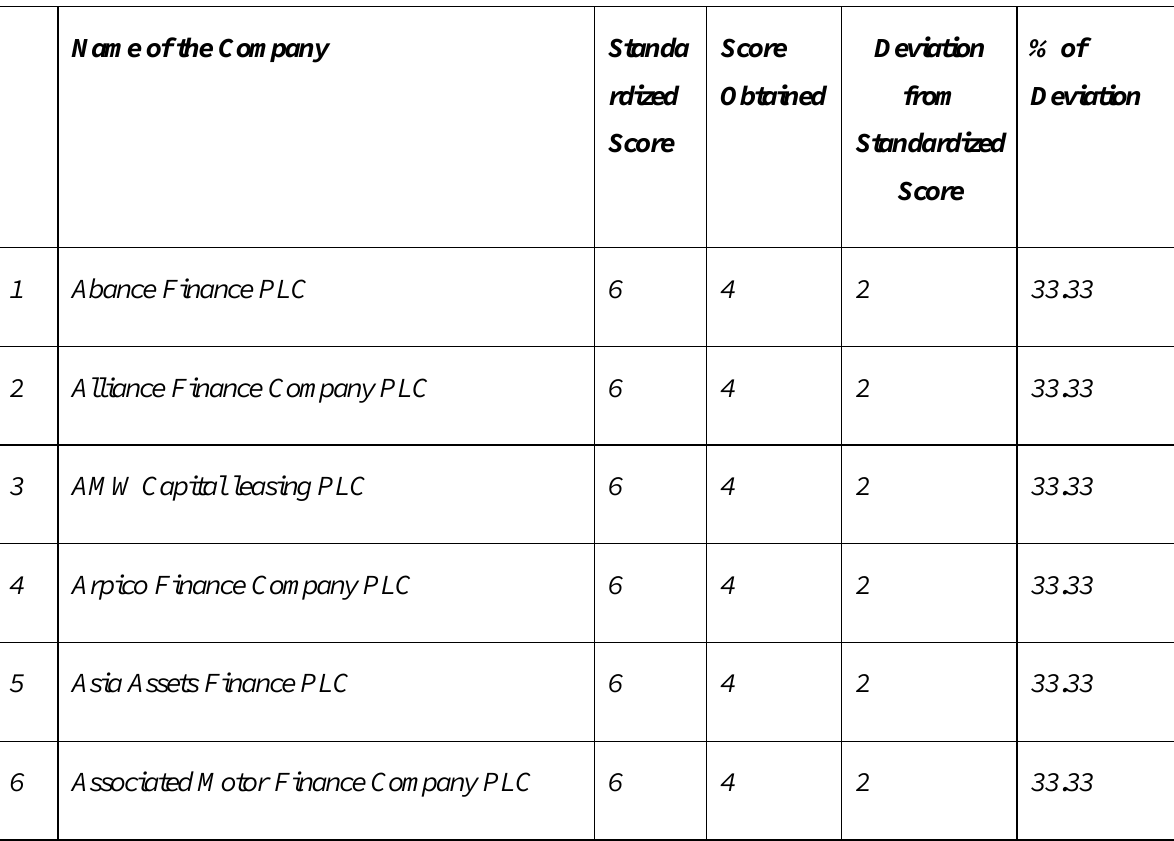
Table 05: Score Board for the compliances as per requirements of paragraph 47 of